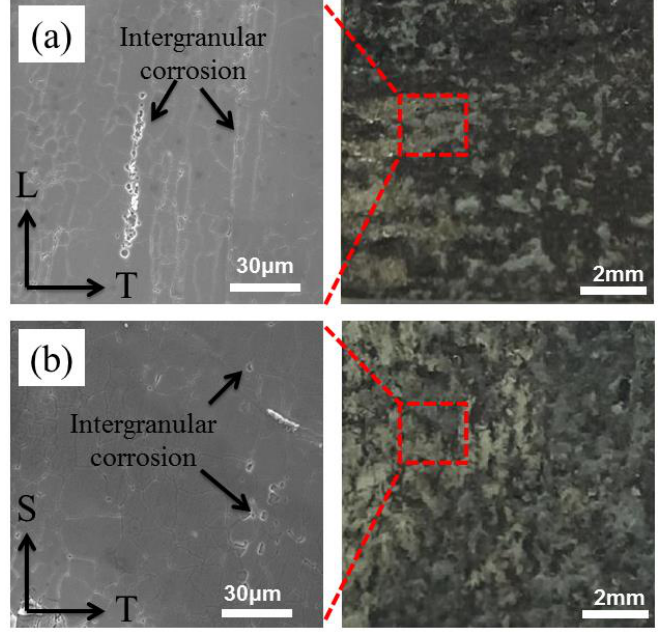
Figure 10. Secondary electron images of the SEM surface morphology of 1.45 wt.%Cu alloy after immersion in EXCO solution for 24 h: ( a ) L-T; ( b ) S-T.